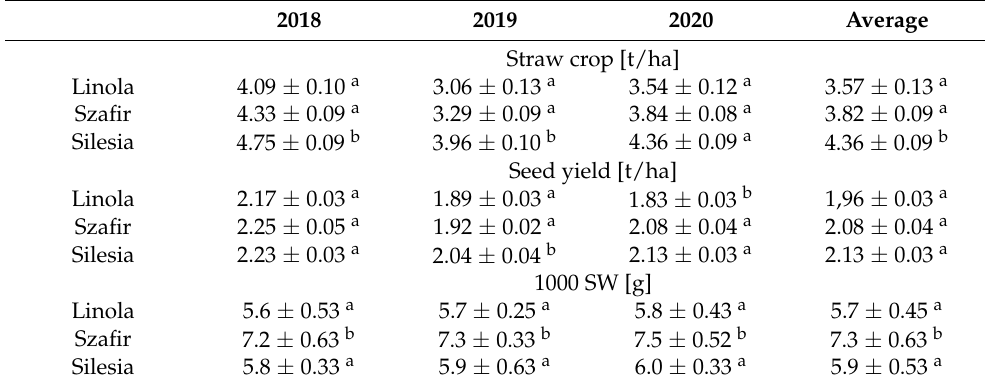
Table 1. Yield parameters of the studied cultivars. Values for the vegetation periods studied and the average values of the varieties. (1000 seeds weight—1000 SW) All results are statistically significant ( p < 0.05). Different superscripts imply significant differences.